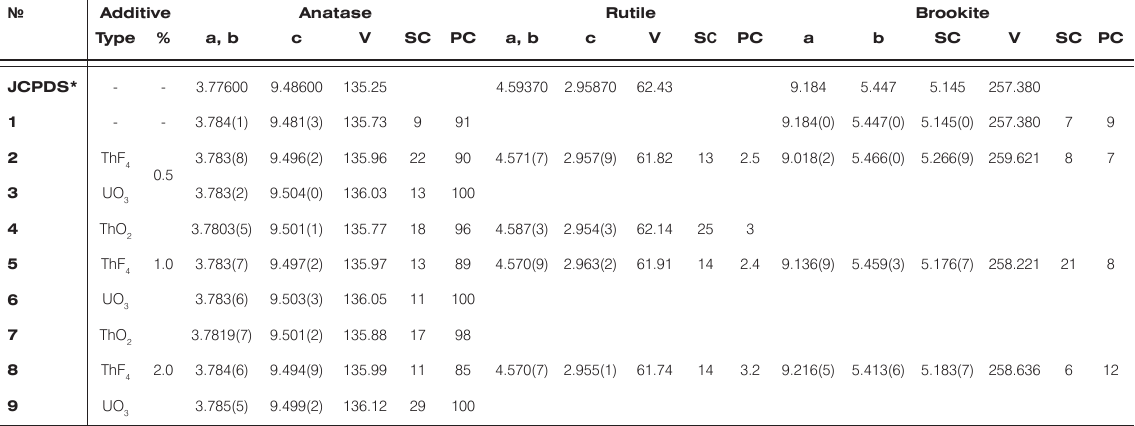
Table 2. Lattice parameters (a, b, c, Ǻ ) size of crystallites (SC, nm), cell volume (V×10 -6 , pm 3 ) and phase composition (PC, %) of the studied